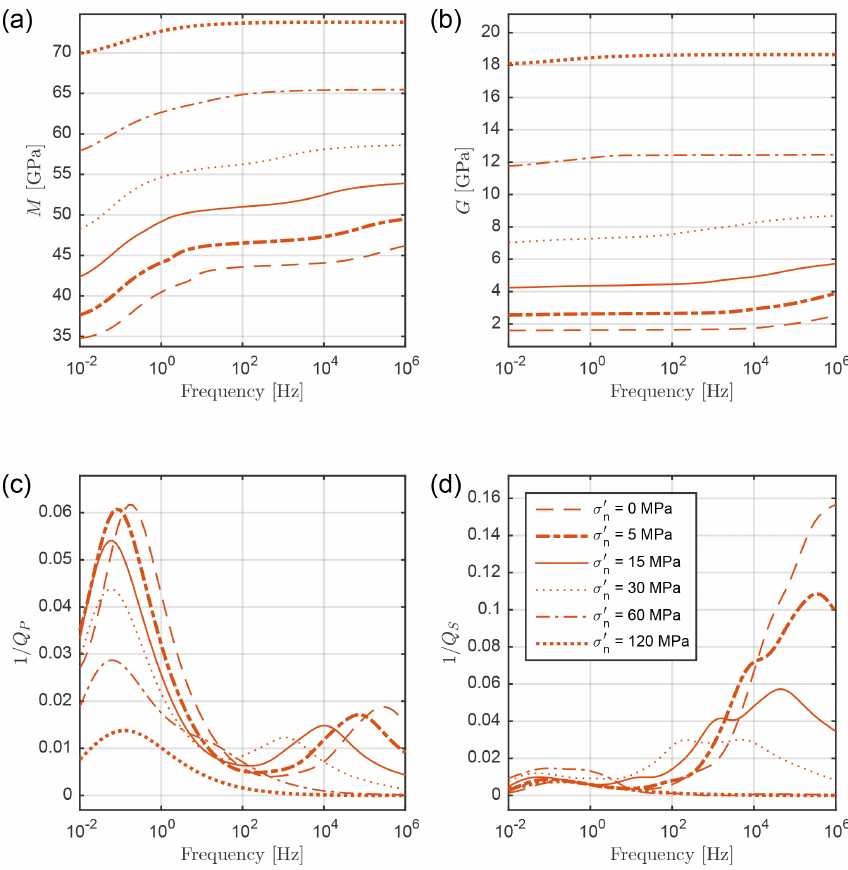
Figure 15. P-wave modulus (a) , S-wave modulus (b) , inverse P-wave quality factor (c) , and inverse S-wave quality factor (d) for varying lithostatic stresses, modeled for a fractured rock with a geometry as shown in Fig. 10 and rock properties corresponding to those of model B. The solid curves are identical to those in Fig.